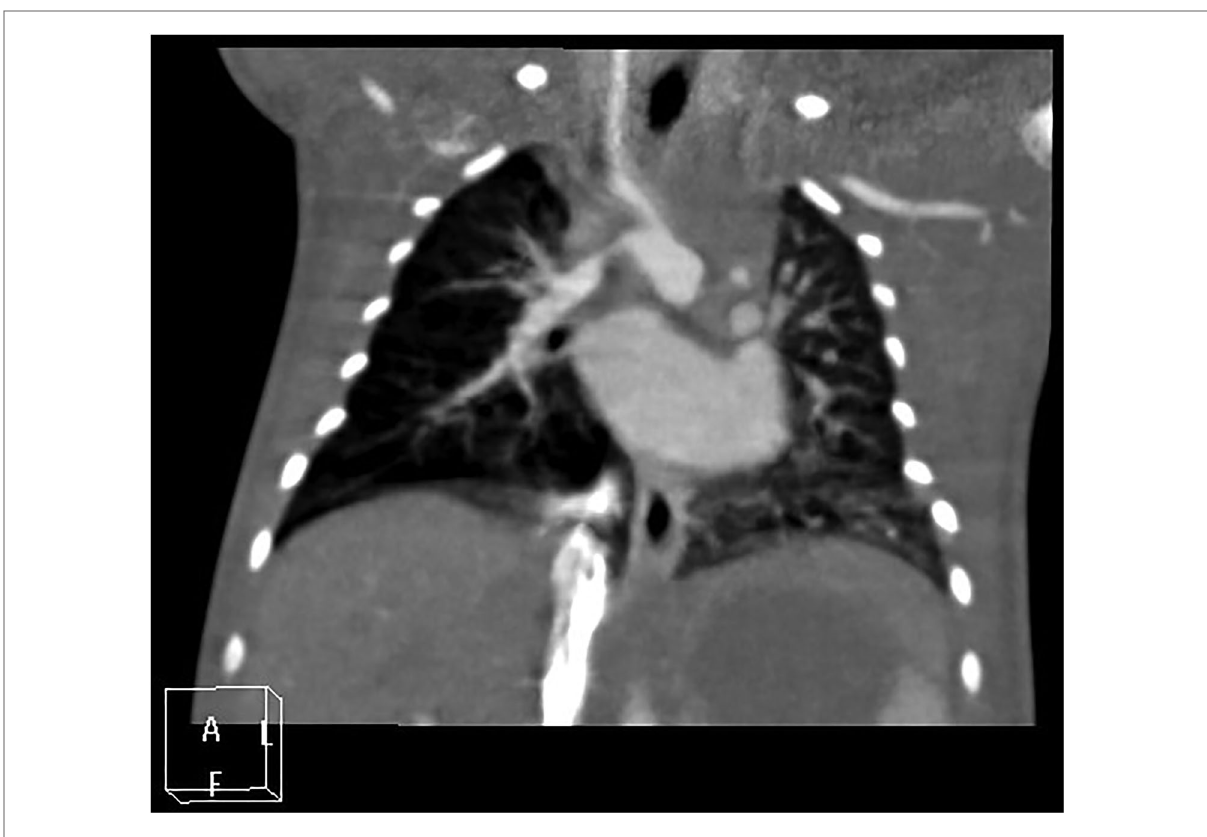
FIGURE 3 Right proximal interruption of the pulmonary artery, with left-sided aortic arch and right-sided patent ductus arteriosus in a 4-day-old female patient. A coronal view of the chest computed tomography angiography shows that the proximal right pulmonary artery is absent, and an open ductus arteriosus connects the proximal brachiocephalic trunk to the distal right pulmonary